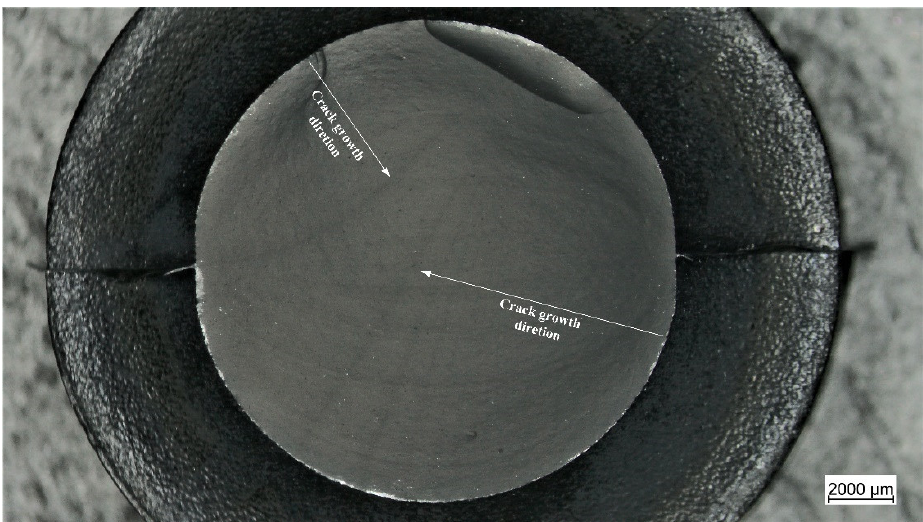
Figure 11. Light microscope picture of the fracture surface of an axisymmetric dumbbell specimen of CB filled NBR after fatigue testing in which two fronts of macroscopic fatigue crack growth are present (displayed by the arrows). The test was performed at a frequency of 4 Hz and a load ratio Rε of 0.5.